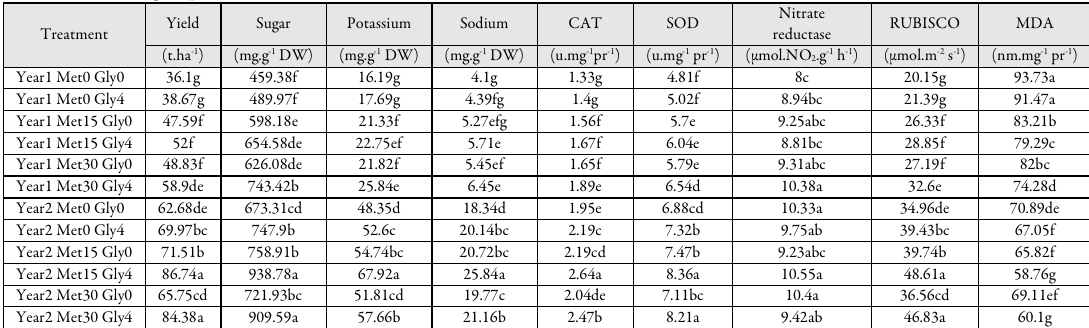
Table 5. Mean comparison of interaction between year, methanol and glycine betaine foliar application on yield, sugar, potassium, sodium, CAT, SOD, nitrate reductase, rubisco